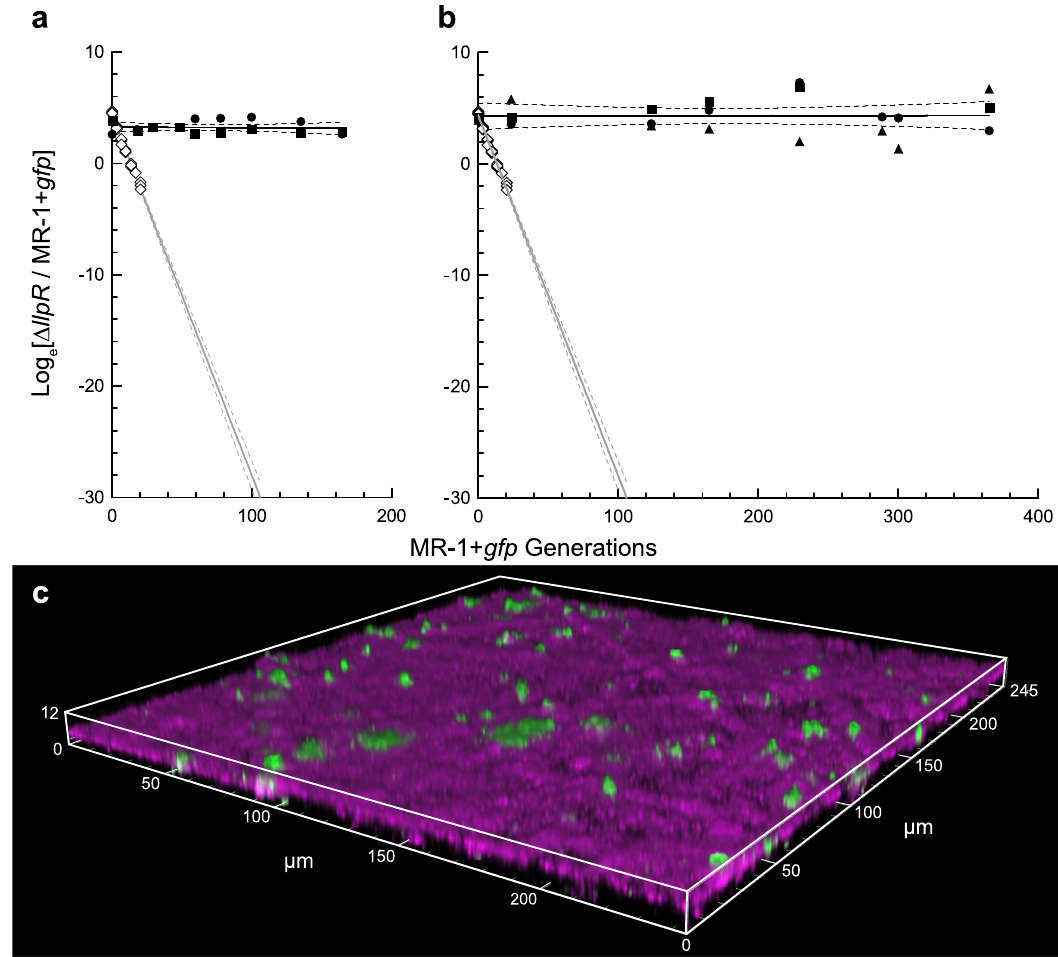
Fig. 3 Bio fi lm competition. Anaerobic competition for lactate in bioreactors with electrodes poised (black circles, squares, and diamond, along with black lines). a Two replicate competitions conducted over 671 h (~165 MR-1 + gfp divisions) with abundances of each strain measured by fl ow cytometry. b Three replicate competitions conducted for 1488h (~365 MR-1 + gfp divisions) and measured by dilution plate counting. For comparison, gray lines extrapolate the planktonic selection in bioreactors with unpoised electrodes (white diamonds). c Confocal microscopy volume projection of a mixed-culture bio fi lm at 929 h con fi rms that MR-1 + gfp cells (green) still sparsely populate the bio fi lm which remains dominated by Δ llpR cells (magenta). Symbols indicate experimental replicates (i.e., one symbol for each bioreactor), solid and dashed lines indicate linear regression and associated 95% con fi dence bands,